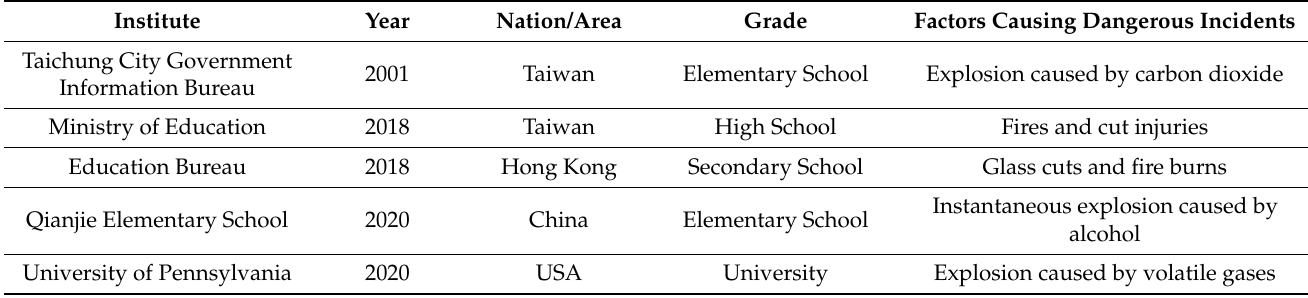
Table 1. Laboratory accidents in different places in recent